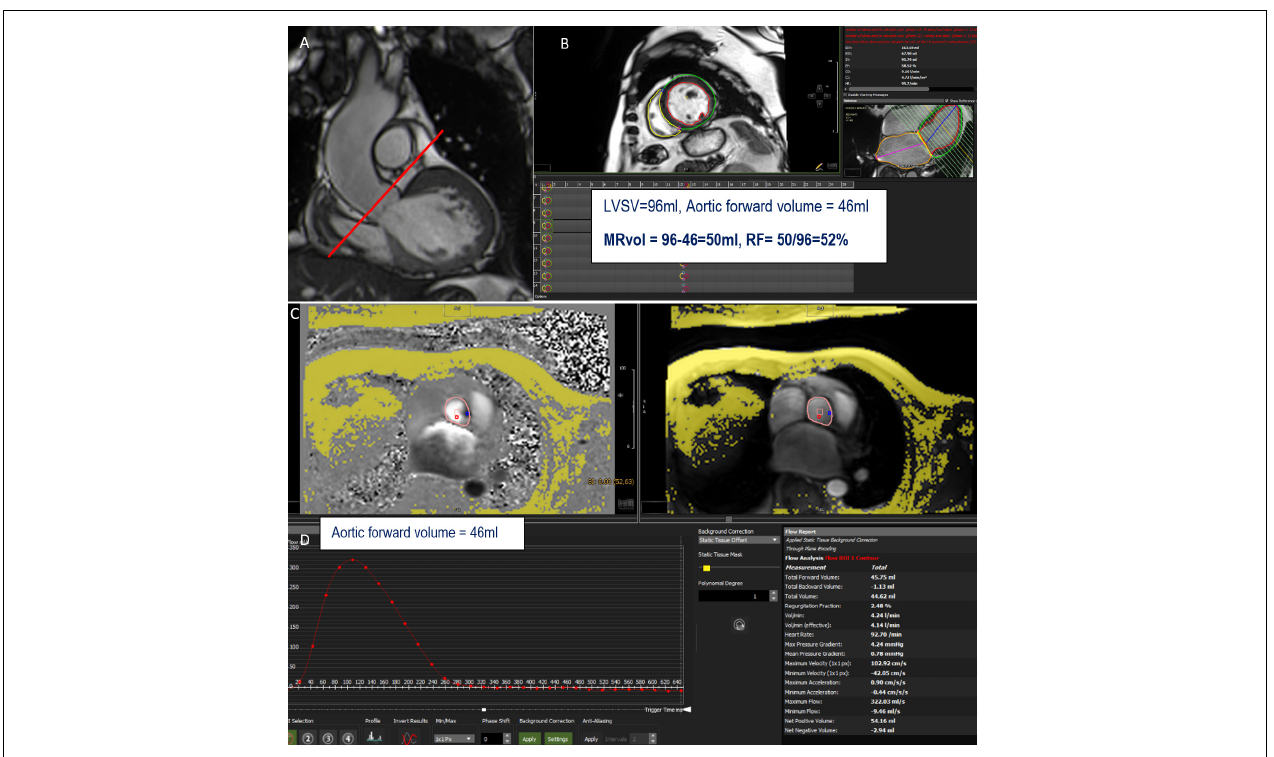
FIGURE 2 | Example of mitral regurgitation (MR) assessment using indirect method n ◦ 1. LVOT bSSFP images show the perpendicular line above the aortic valve (red line) indicating the slice position for phase-contrast velocity mapping (A) . Assessment of left ventricular stroke volume (LVSV) from short-axis cine SSFP images (B) . Phase and magnitude images with delineation of the aorta (C) generating flow curves (D) . This patient has a severe MR with a mitral regurgitant volume (MRvol) of 50 ml and a regurgitant fraction (RF) of